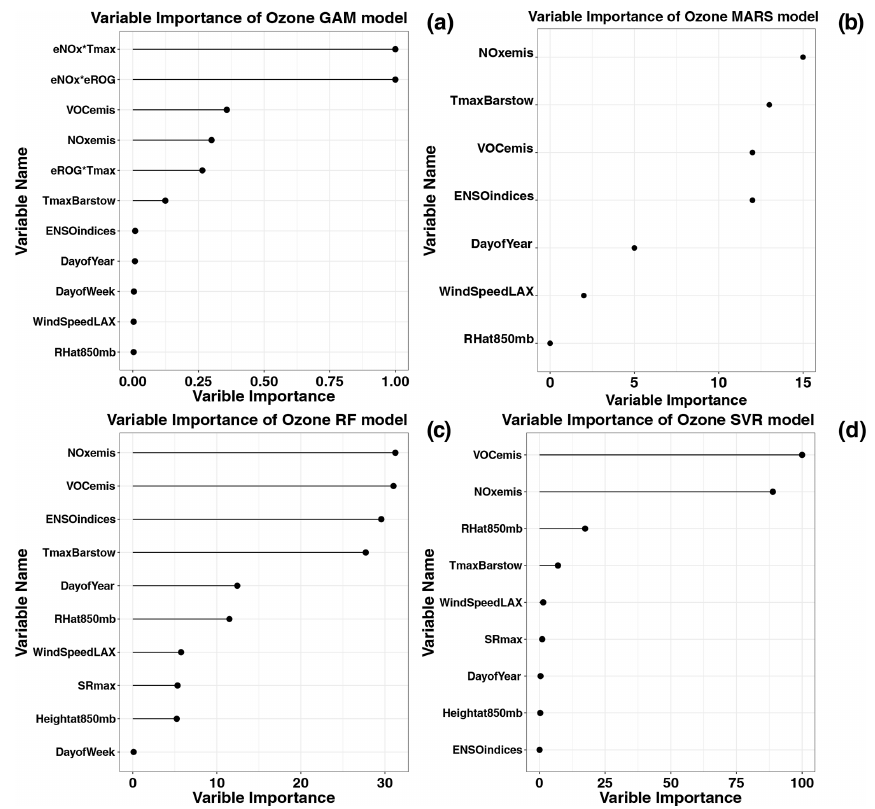
Figure 4. Variable importance for simulations of the top 30 MDA8 ozone days using the GAM-SoCAB-8HR V1.0 model (a) , MARS- SoCAB-8HR V1.0 model (b) , RF-SoCAB-8HR V1.0 model (c) and SVR-SoCAB-8HR V1.0 model (d) . The variable importance for each model is calculated with different methods (see text). SR: solar